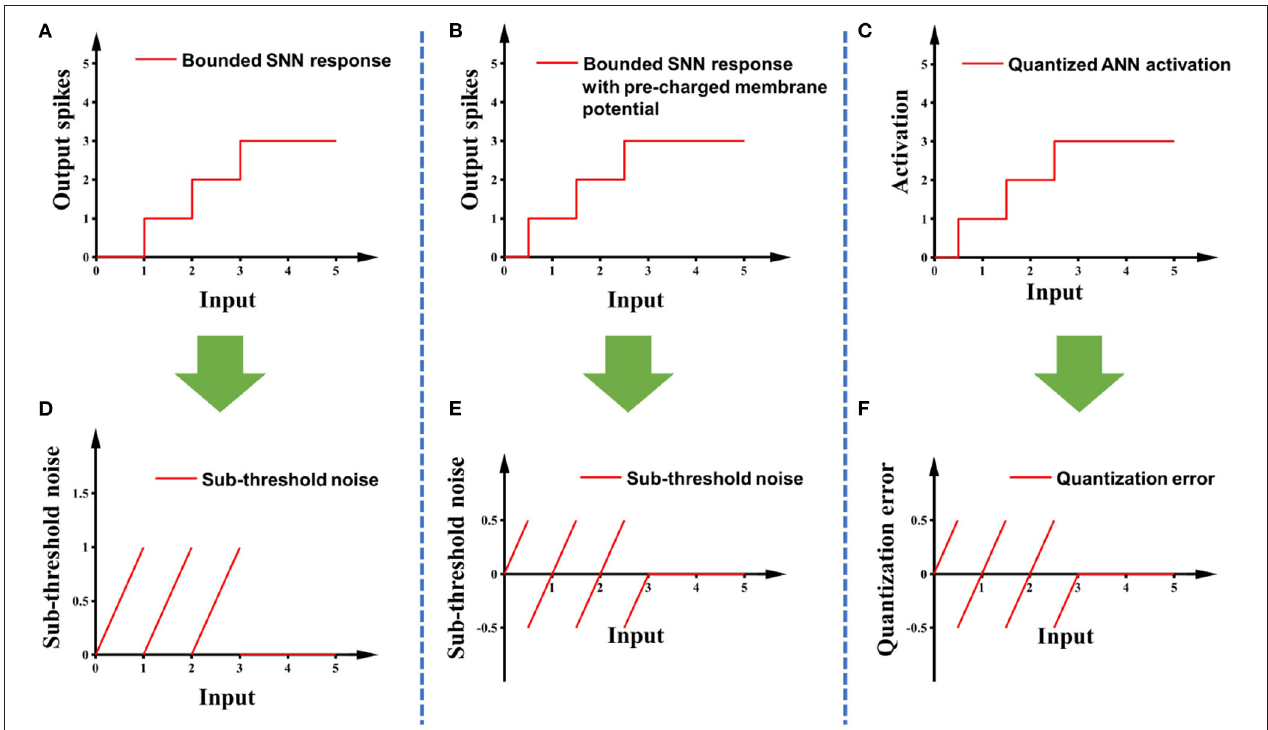
FIGURE 4 | (A) The response curve of the modified IF model with the maximum spike count bound of 3; (B) adding pre-charged membrane potential to (A) ; (C) the response curve of a 2-bit quantified ANN; (D,E) are the sub-threshold noise of (A,B) , respectively, compared with clipped ReLU; (F) is the quantization error of (C) relative to clipped